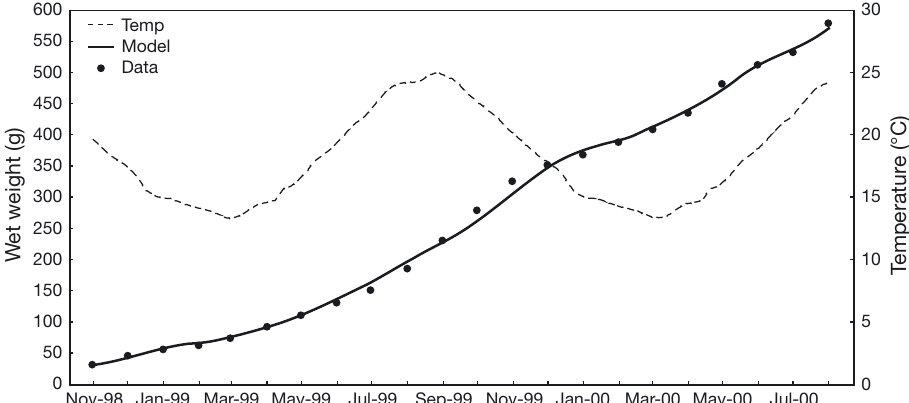
Fig. 2. Calibration of the Dicentrarchus labrax growth model. Dashed line corresponds to the water temperature (°C); continuous line represents the wet weight (g) predicted by the model; dots indicate the wet weight observations